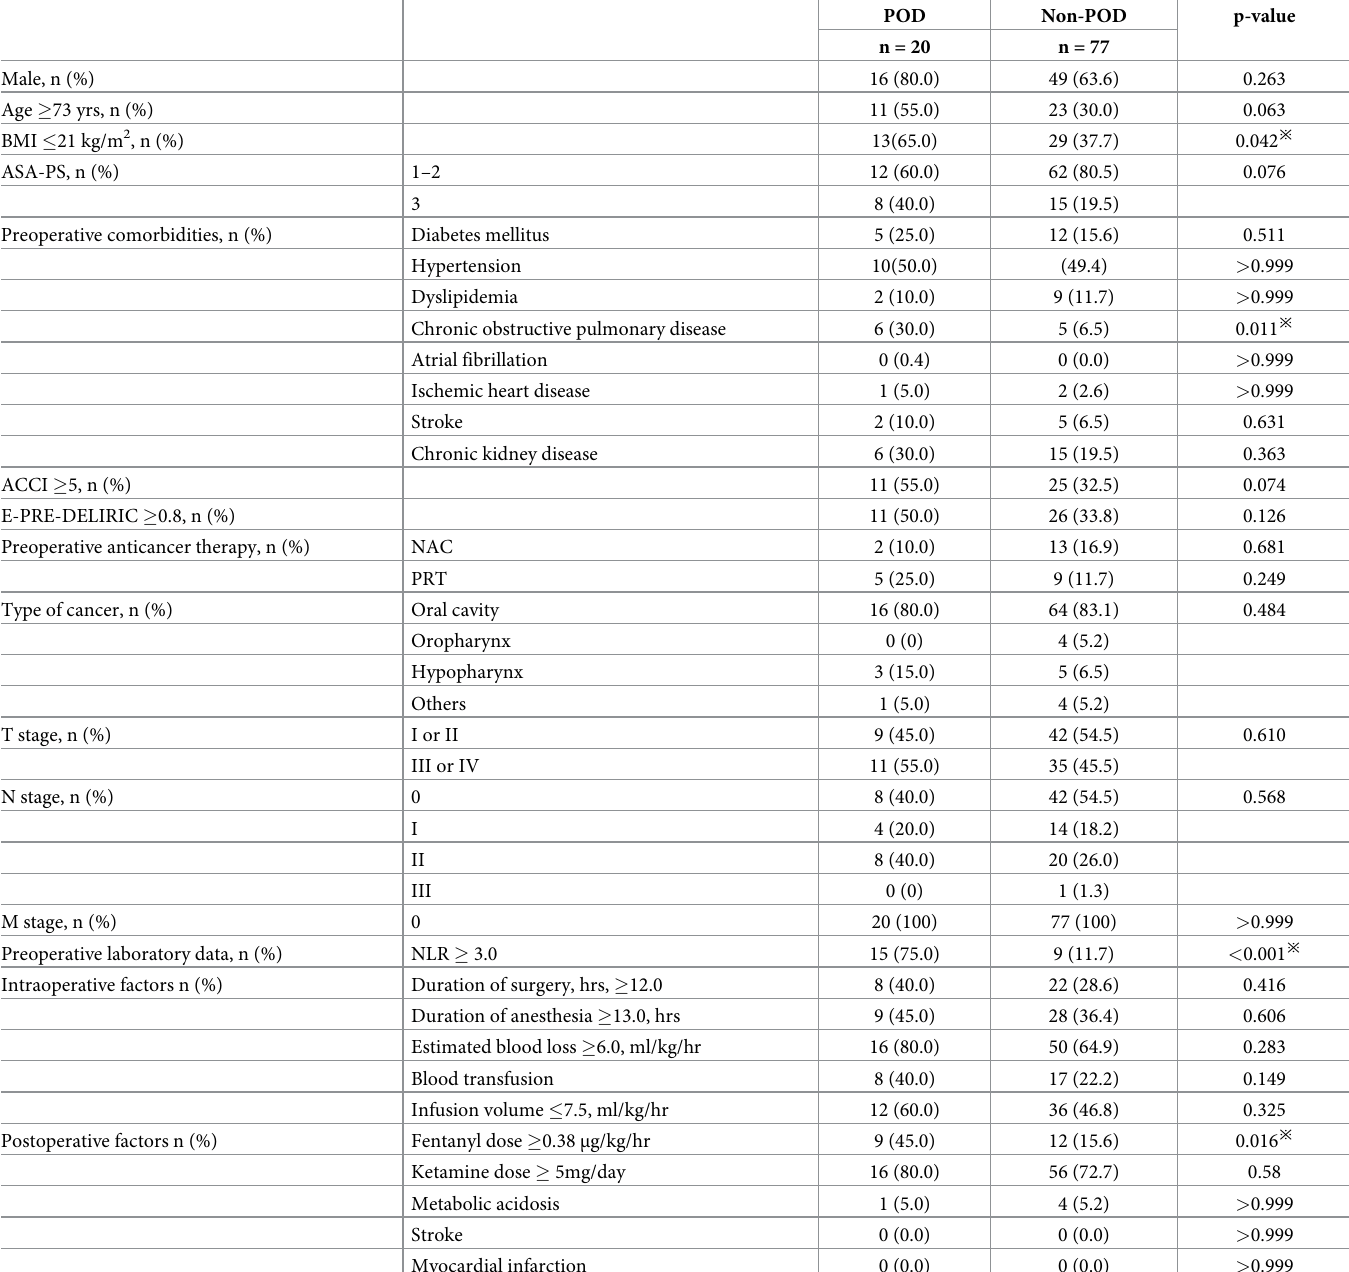
Table 1. Patient characteristics and perioperative data in the patients with or without